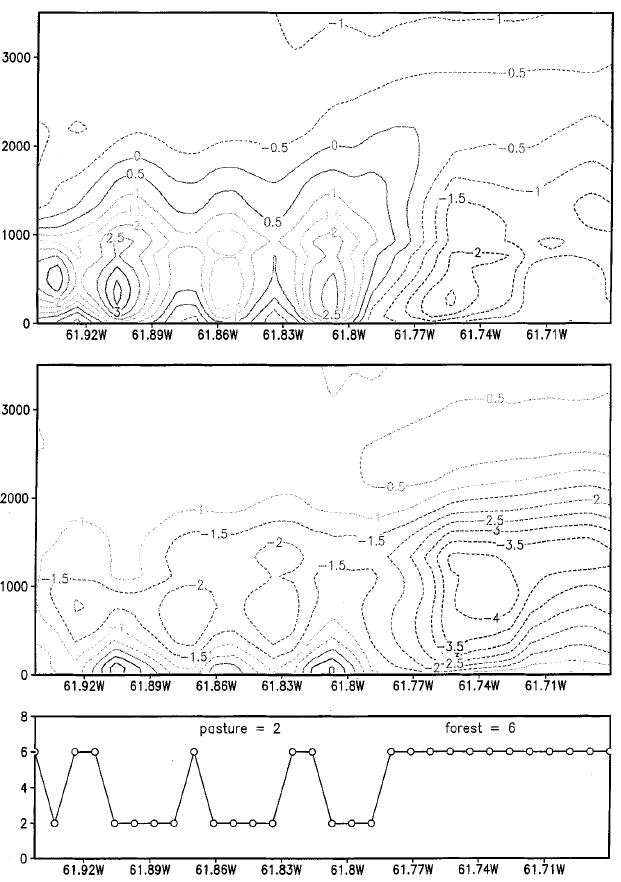
Fig. 12A–C. Cross section at 10 (cid:176) 6 ¢ S of vertical velocity (cm/s) at 20 August using RAMS at A 13.00 local and B 17.00 local time. C shows the land